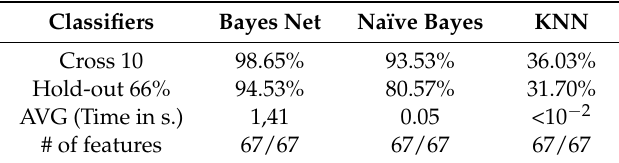
Table 13. Results using all features for IAM Online Handwriting